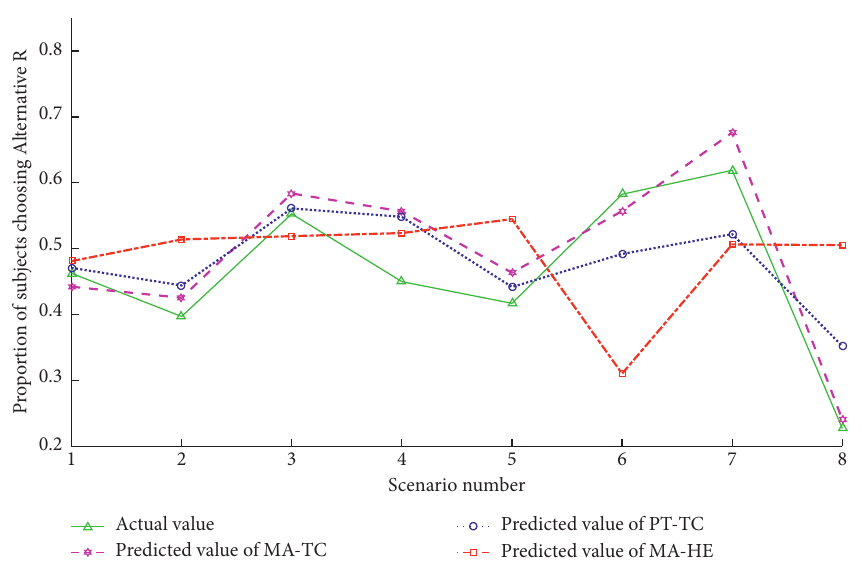
Figure 4: Fitting curve under deterministic conditions.